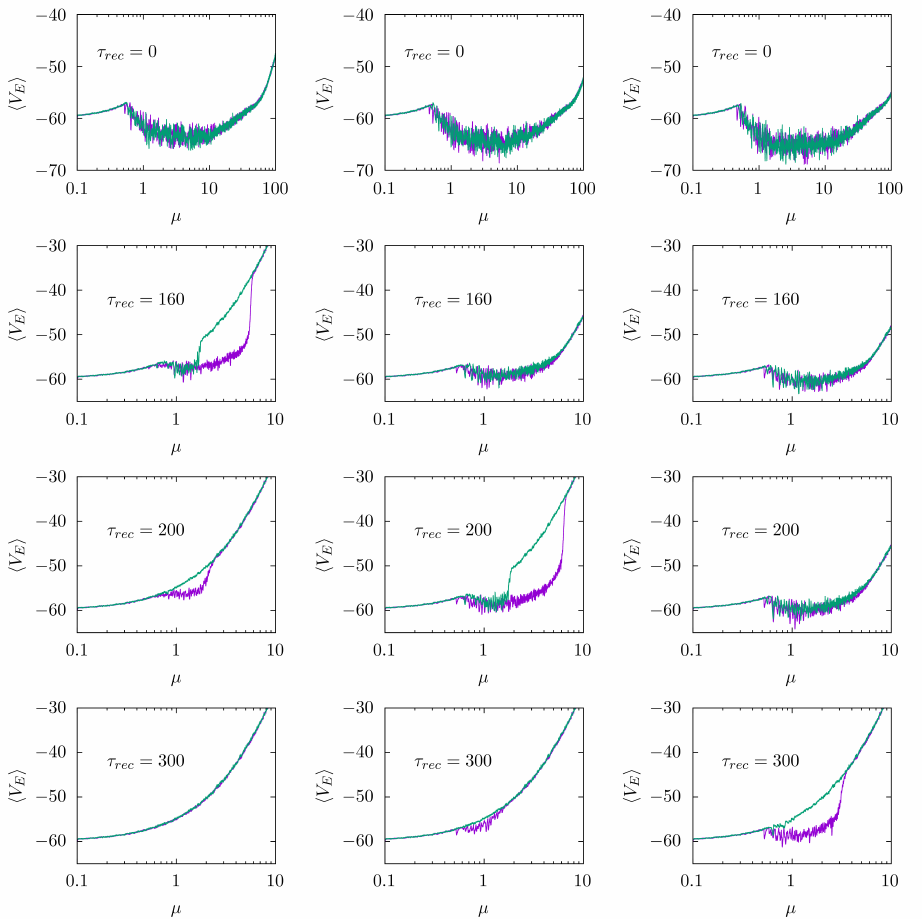
Figure 2. Evidence for sharp changes in emergent EEG-like waves as the noise level µ varies adiabatically and when synaptic depression is set on. Purple line corresponds to the adiabatically forward (positive) variation of the noise level µ whereas green line corresponds to a backward = 8,10 and 12 mV, (negative) adiabatic variation. Columns correspond, from left to right, to V d 0 = − 4 V d respectively. In all cases V h , U = 0.5, τ 1 = 16 ms, τ 2 = 26 ms and the amplitude of the 0 0 external depolarizing inputs is V d o = 5.48 mV. This corresponds to a module with 196 E’s and 49